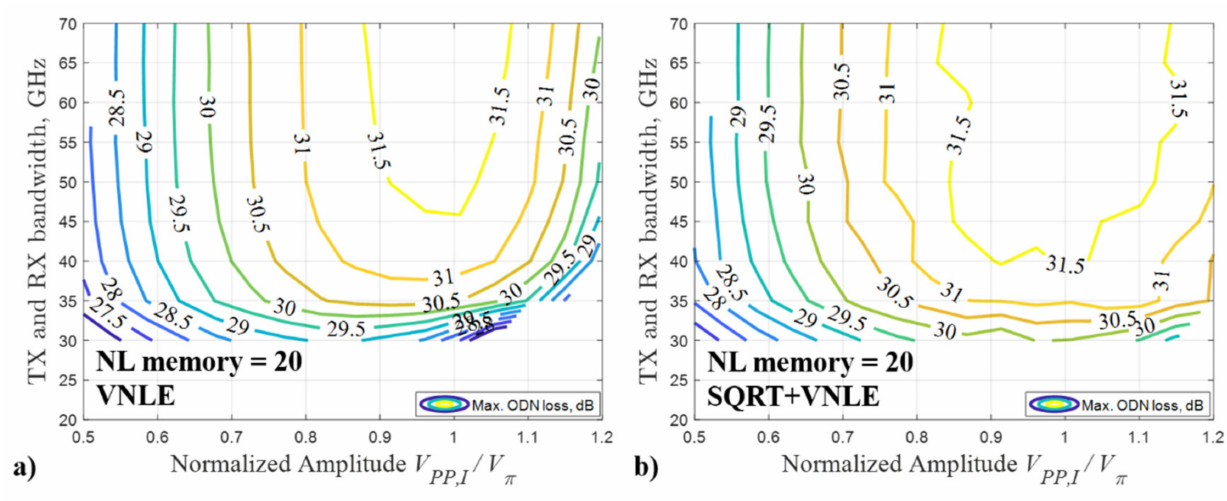
Figure 5. Maximum ODN loss at BER T = 10 − 2 as a function of TX and RX bandwidth and of the normalized peak-to-peak amplitude of the in-phase signal V PP , I / V π with NL memory = 20 samples. The fiber length is L = 20 km. The transmitted optical power is TOP = 15 dBm: ( a ) VNLE; and ( b ) SQRT +